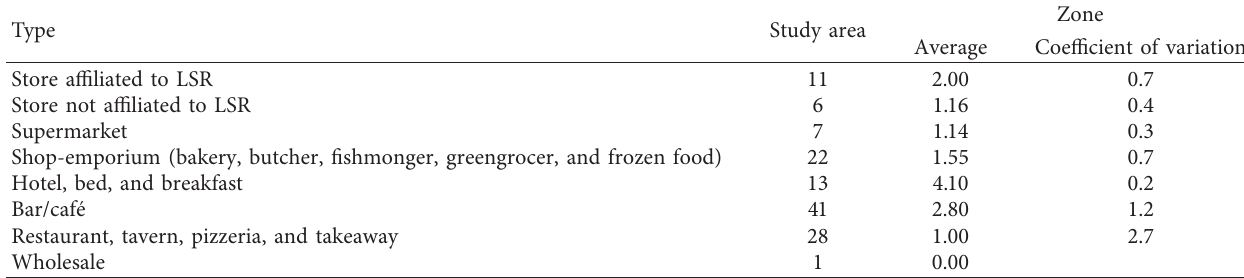
Table 5: Retail data: number of